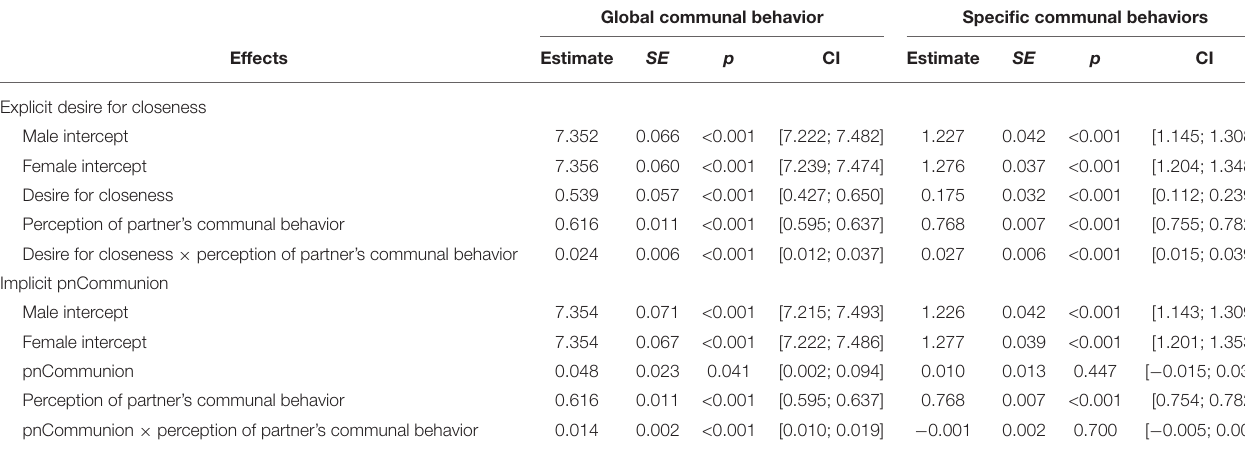
TABLE 3 | Results of multilevel analyses for the prediction of communal behavior by perceptions of partner’s communal behavior and communal motives.